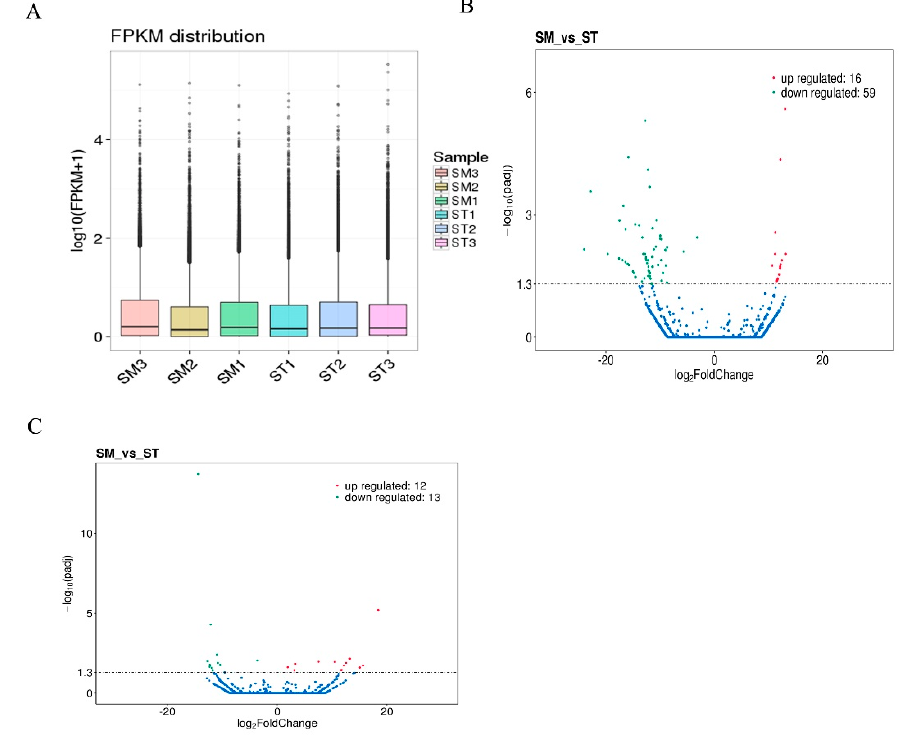
Figure 2. Screening and clustering analysis of di ff erentially expressed lncRNAs and mRNAs. ( A ) Distribution of lncRNAs expression level. The expression was normalized with fragments per kilobase per million mapped reads (FPKM). ( B ) The volcano plot distribution of di ff erentially expressed lncRNAs. ( C ) The volcano plot distribution of di ff erentially expressed mRNAs. The validation results for the randomly selected di ff erentially expressed lncRNAs and di ff erentially expressed mRNAs indicated that the results were similar to the RNA-seq, suggesting that the results of RNA-seq were reliable (Figure